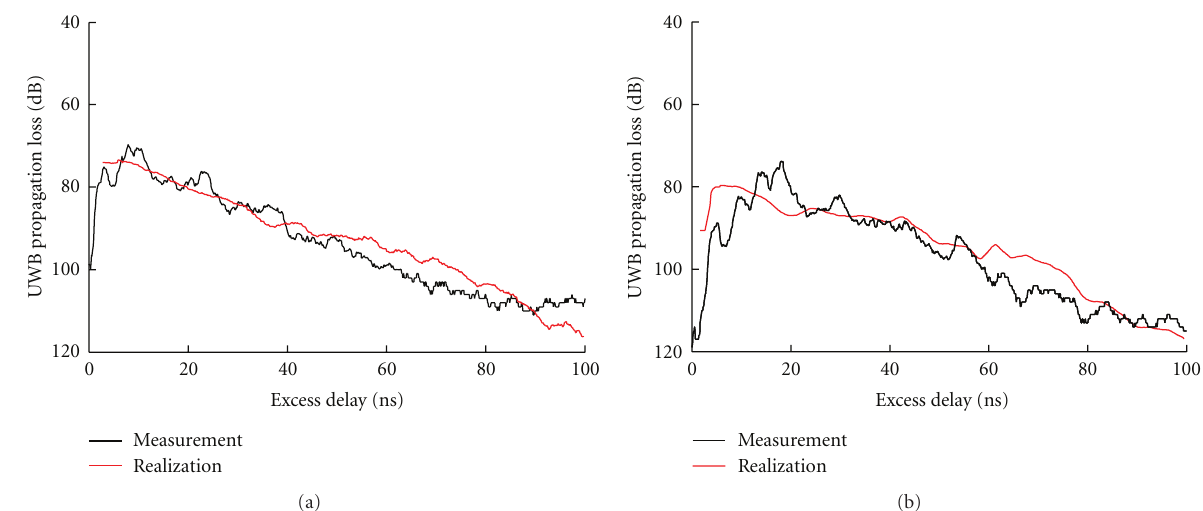
Figure 12: Comparison of the APDPs between 20 realizations and measured delay profiles of Room E ( V = 5m 3 ): (a) LOS and (b) NLOS.